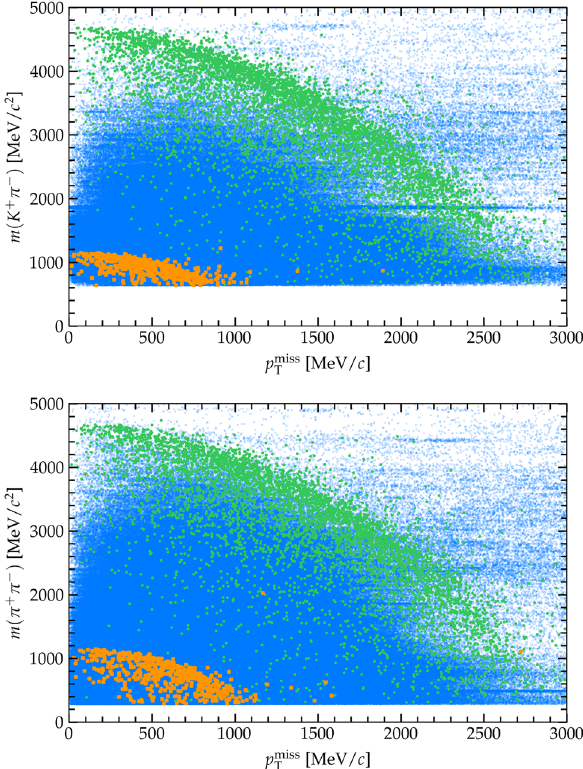
+ → ψ h − for Λ 0 DS h b 1 2 T + π − . Bottom: Λ 0 → ψ → ψ π + π − . Blue DS K DS b b → π + π − is clearly S